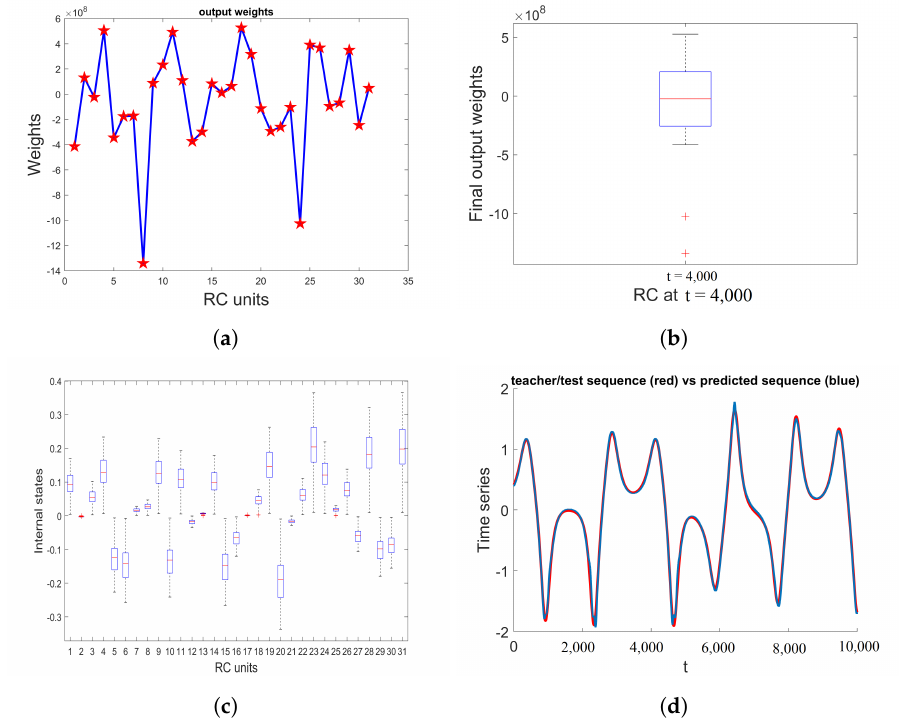
Figure 3. Training and prediction results of the RC model for u ( t ) state variable of the model (1) at σ = 1. The 70% of input data are used as a teacher sequence, whereas the last 30% of the data are set as the validation test data. ( a ) The weights of RC nodes after the completion of training. ( b , c ) The spread of the weights of RC units, illustrated by using a box-and-whisker plot. ( d ) The training and test data in red color vs. predicted data in blue